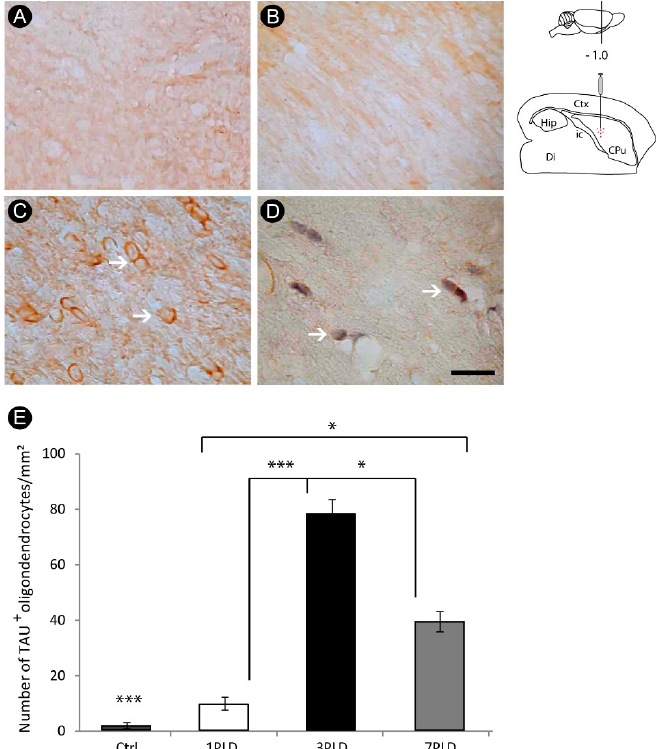
Figure 6. Oligodendrocyte damage in the internal capsule following endothelin − 1 (ET − 1) injection. Control ( A ) and endothelin-1-injected groups at 1PLD ( B ), 3PLD ( C ) and 7PLD ( D ). The peak of Tau + cells is observed at 3PLD, as confirmed by quantitative analysis ( E ) (* p < 0.05; *** p < 0.001, ANOVA, Tukey post hoc test). Values expressed as mean ± SEM. Arrows in ( C ) and ( D ) point to TAU + oligodendrocytes. Drawings at the left side of the figure show the anatomical localization of the ET-1 injection in the striatum. Ctx: cortex; CPu: caudate putamen (striatum); Di: diencephalon; Hip: hippocampus; ic: internal capsule. Scale bar: 50 μ m.